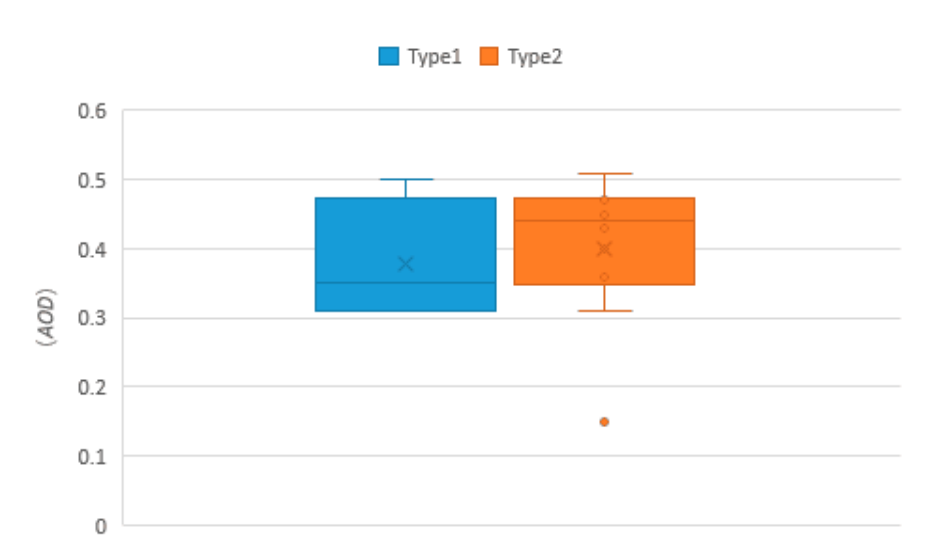
Figure 12. Box plot analysis results for different city levels.